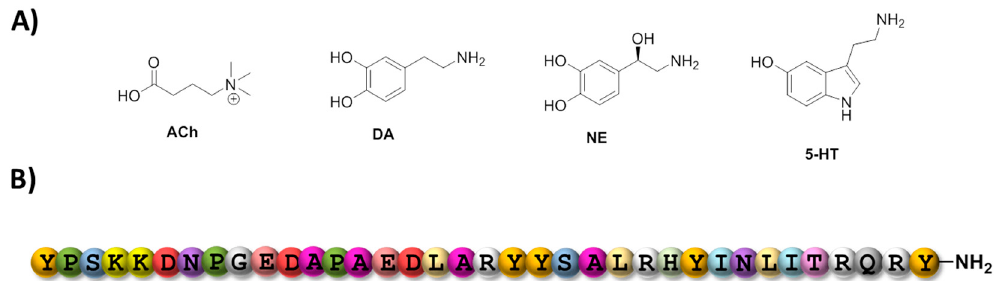
Figure 3. ( A ) Chemical structure of the main biogenic monoamine neurotransmitters; and ( B ) amino acid sequence of neuropeptide Y [96].